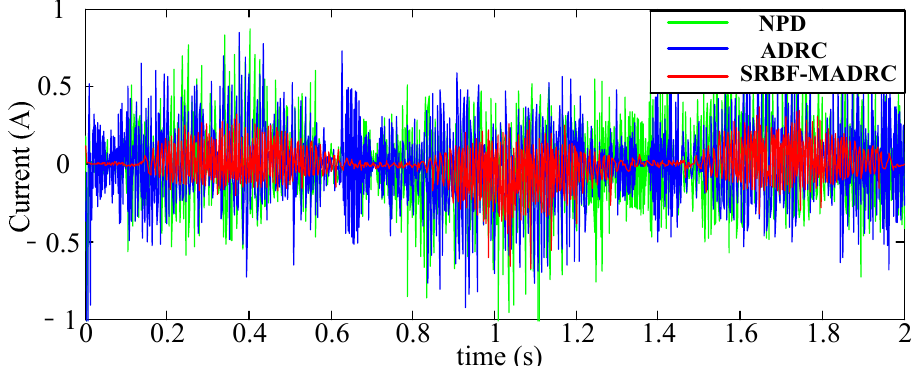
Figure 15. Motor current envelope of three algorithms.